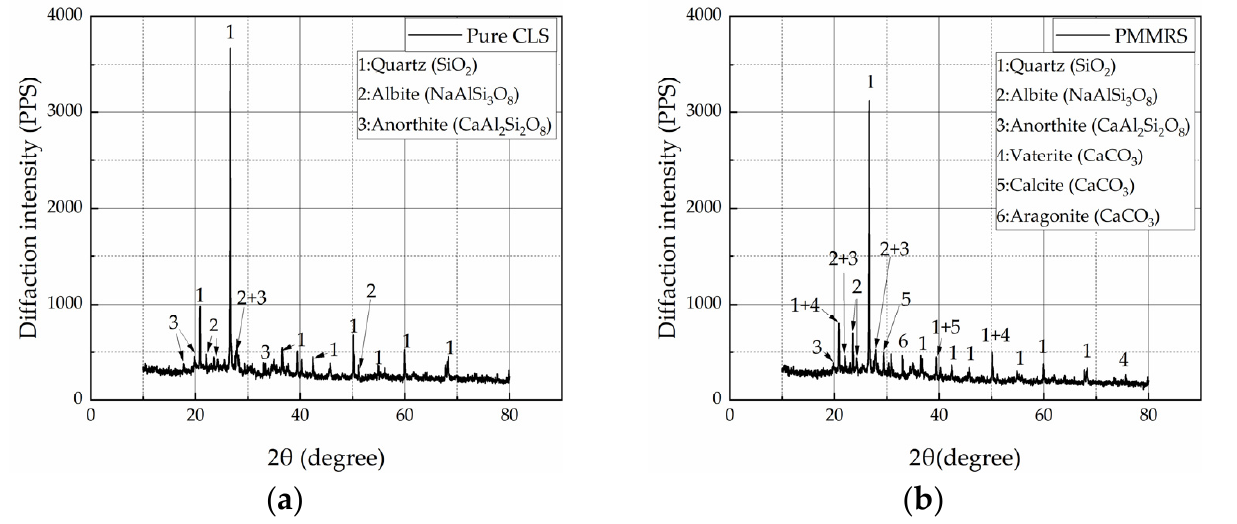
Figure 12. FESEM imagines of ( a ) pure CLS and ( b ) PMMRS.